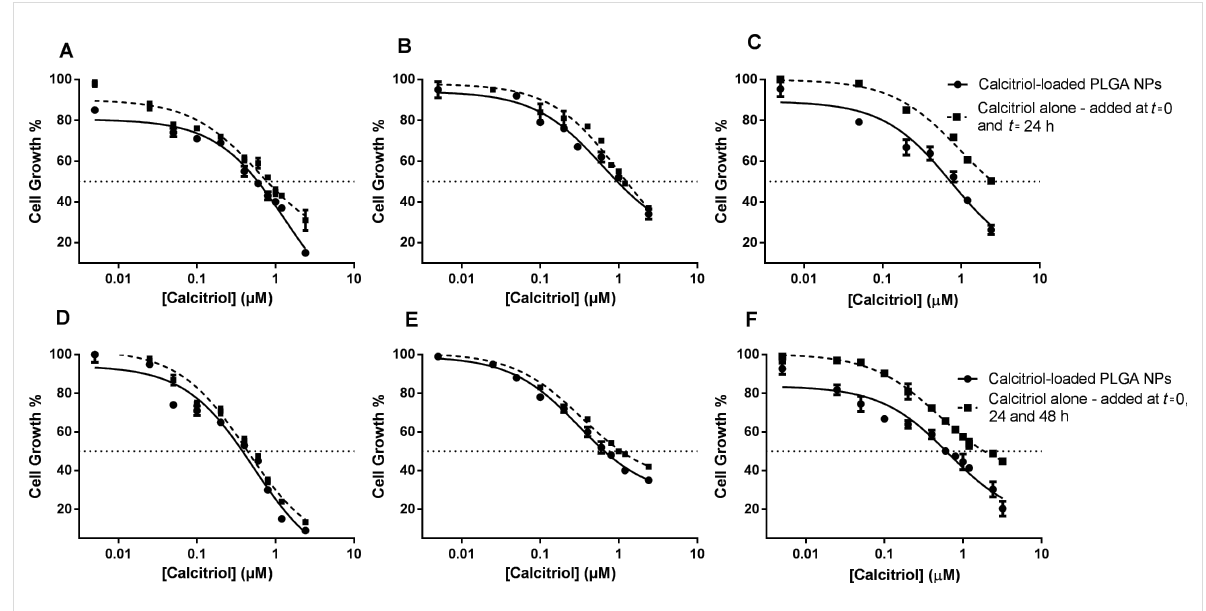
Figure 5: Cytotoxic effects of calcitriol free and calcitriol entrapped in PLGA NPs after 48 h (A–C) and 72 h (D–F) treatment on the cell growth of three human cell lines, (A,D) S2-013, (B,E) hTERT-HPNE and (C,F) A549, determined by a SRB assay. Free calcitriol is represented with squares and a dotted line; and calcitriol–NPs with spheres and a solid